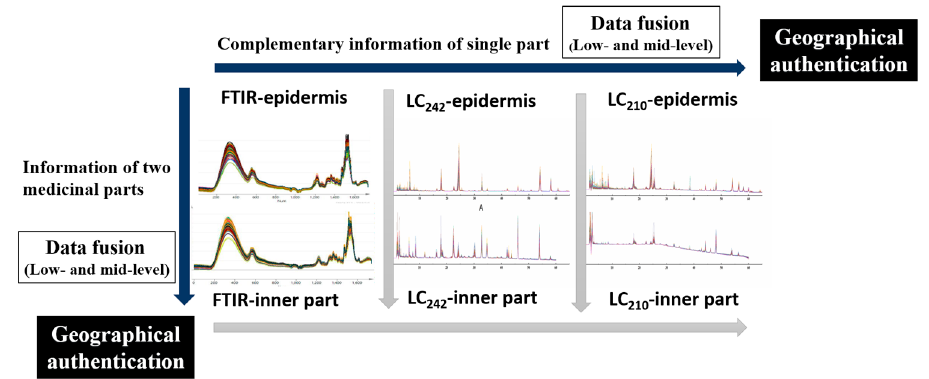
Figure 5. The workflow of geographical authentication using data fusion.